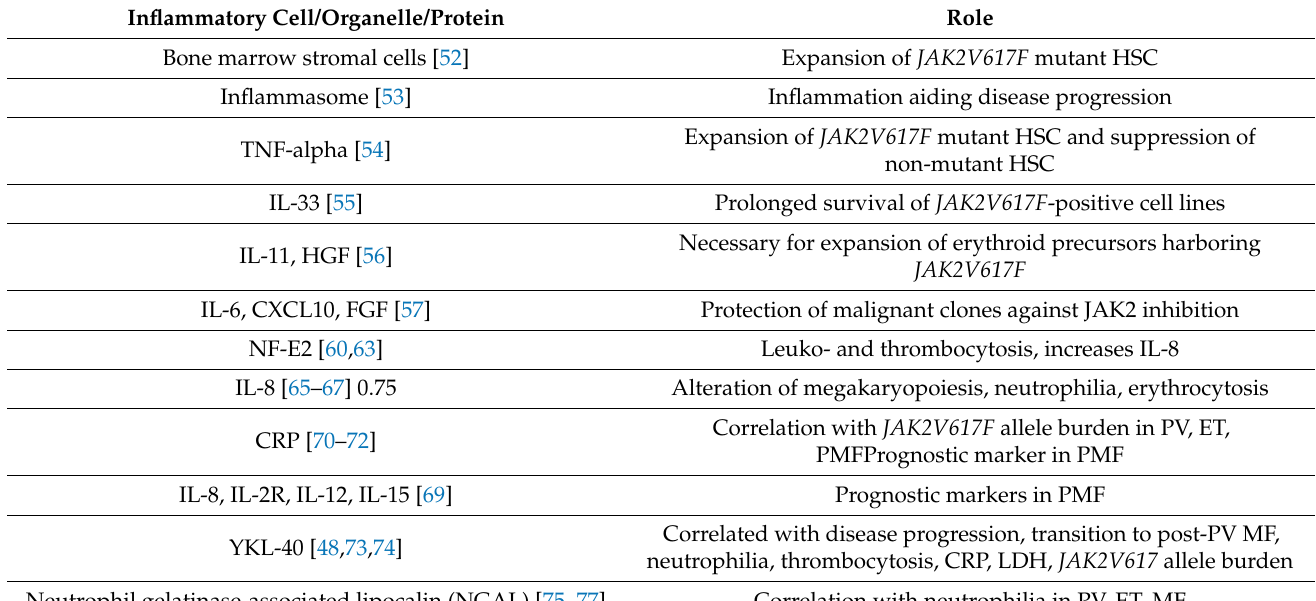
Table 1. Overview of the roles of important inflammatory markers in